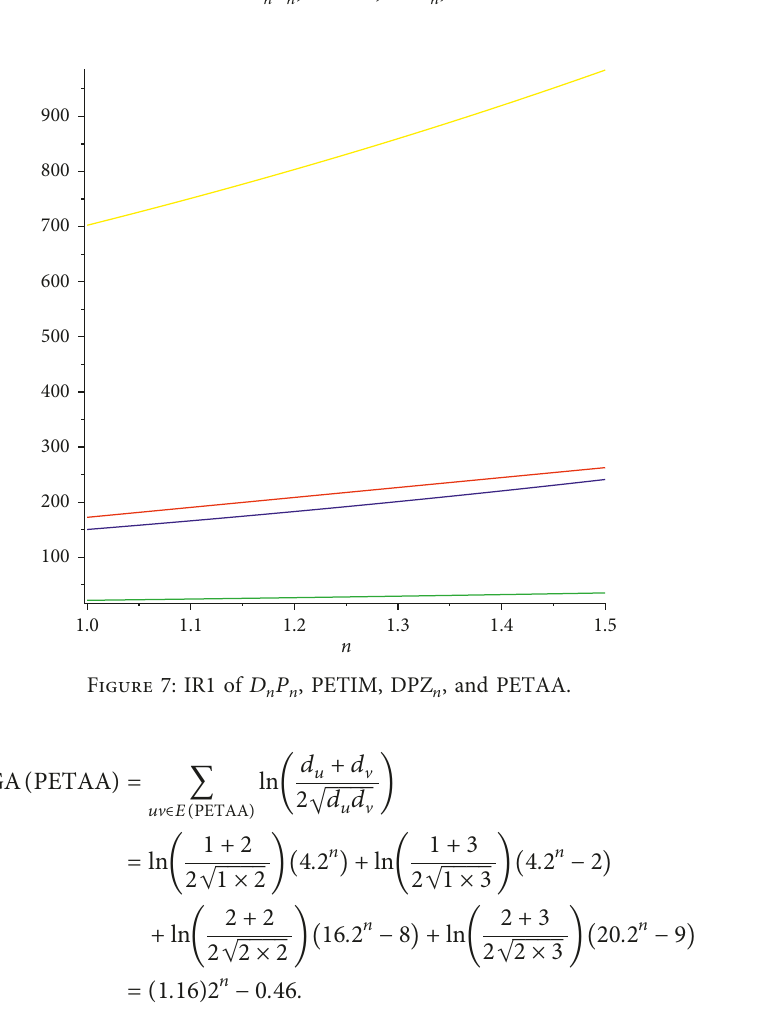
Figure 6: AL of D